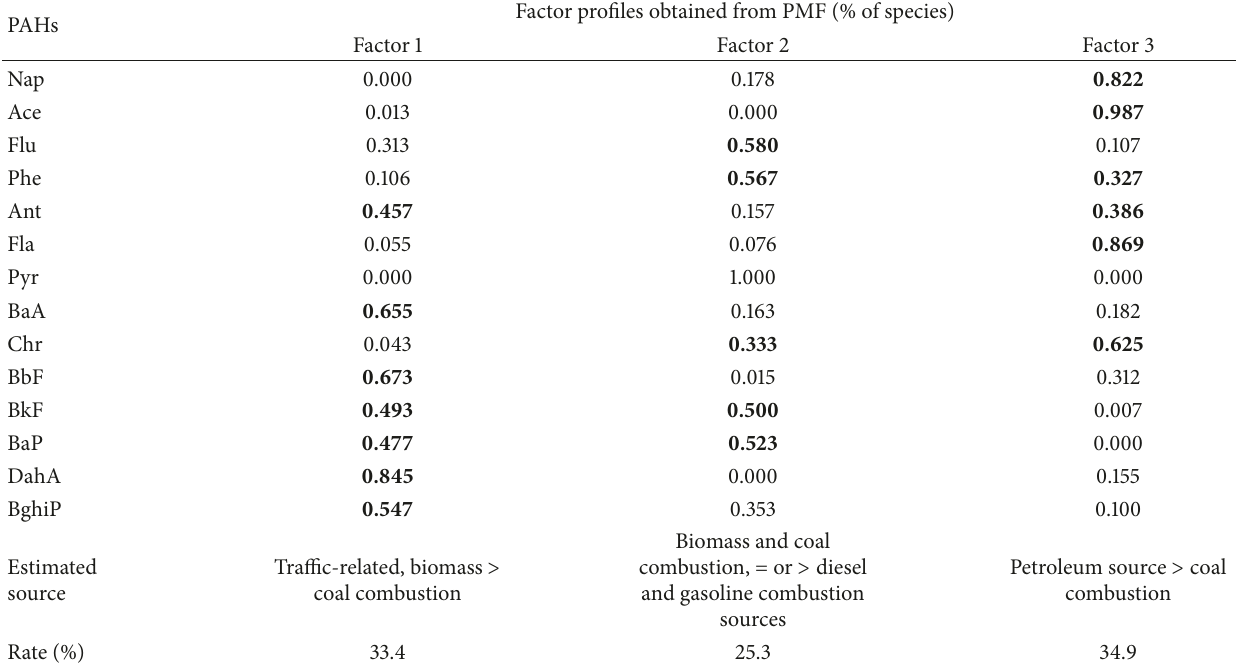
Table 4: Factor profiles ( 𝐹 matrix) of individual PAHs in each of the three PMF factors identified in the analysis of Qinhuai River sediment data set.